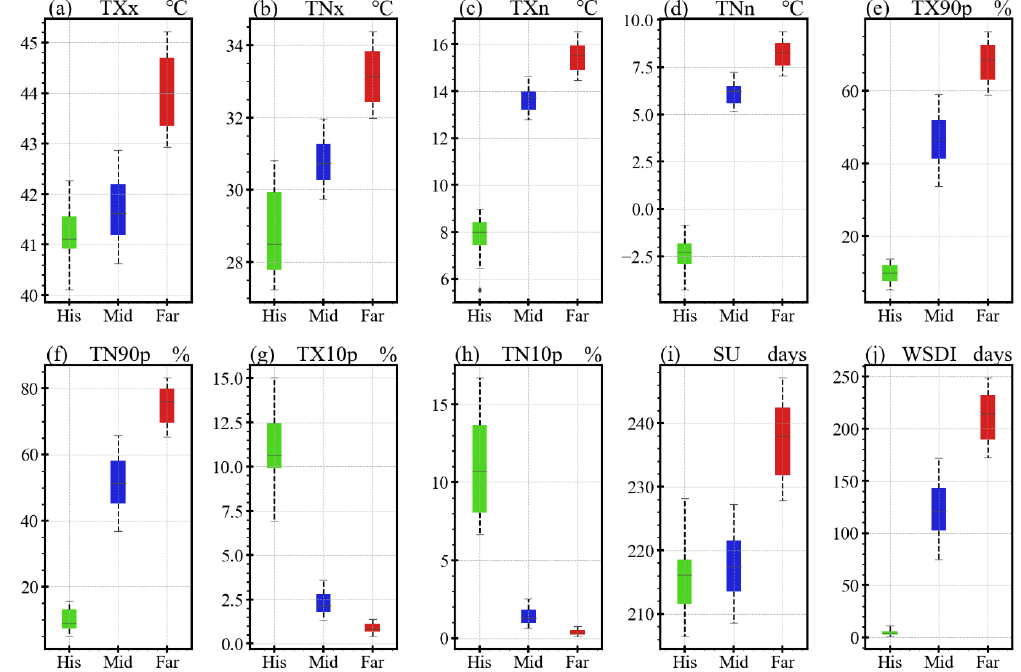
Figure 16. Same as Figure 15, but for the SSP5-8.5 scenario.